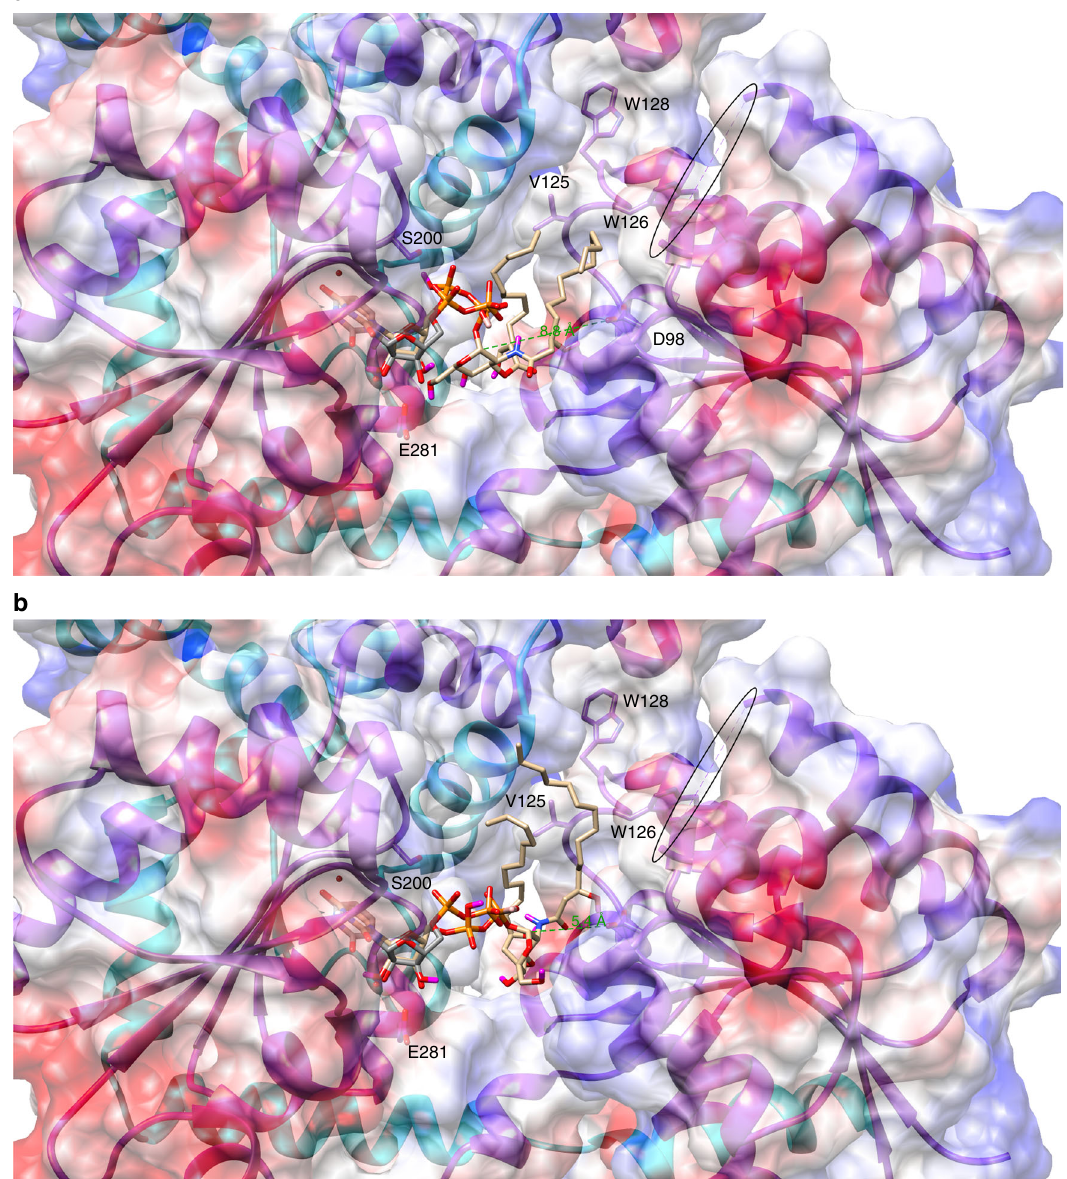
Fig. 6 Molecular docking model of UDP-DAG binding. UDP-DAG (tan carbons) was docked into the LpxB active site cleft with AutoDock Vina 56 . The software correctly identi fi ed the nucleotide-binding site overlaying reasonably well with the position of UDP (gray carbons) observed in the crystal structure. The lipid tails were predicted to extend toward a hydrophobic groove lined by V125, W126, and W128. The break in the chain corresponding to the disordered loop is circled. a The top ranked model places the anomeric carbon 8.8 Å from the predicted catalytic base, D98. b A lower ranked model (seven of nine) places the anomeric carbon 5.4 Å from D98, which would require less movement of the protein in order to correctly orient D98 and the 6 ′ - hydroxyl of lipid X for proton transfer and nucleophilic attack on the anomeric Although native LpxB6S bipyramidal crystals diffracted beyond 2.4 Å (Table 1), LiBr (Sigma-Aldrich), and 0.1M Tris-HCl pH 8.6. Switching from LiCl to LiBr was selenomethionine (Sem) derivative LpxB6S crystals that diffracted well enough for essential for obtaining harvestable LpxB7S Sem derivative crystals. phasing by single-wavelength anomalous diffraction could not be grown. E. coli LpxB has 13 Met, more than adequate for phasing a 42 kDa protein. We hypothesized that one or more of these methionines was interfering with crystallization in the Sem derivative, possibly by being surface exposed and decreasing protein solubility. Thus, we further utilized the Phyre2 homology model of LpxB to predict possible culprits. Three Met residues were identi fi ed and mutated to Ser; however, only M207S preserved the stability of LpxB6S as judged by size exclusion chromatography (Supplementary Fig. 1). M46S and M295S increased protein aggregation. Thus, the Sem derivative of LpxB6SM207S (LpxB7S) was selected for further crystal screening. Hexagonal rod crystals of the LpxB7S Sem derivative that diffracted to 3.43Å (Table 1) were obtained in a 2 μ l drop of 8 The selenomethionine anomalous diffraction data were used to calculate the mg ml − 1 LpxB7S (0.9 μ l), well solution (0.9 μ l), and 0.2 μ l of 100 mM trimethyl- initial phases and to build a crude model: AutoSol found 11 Se sites with a fi gure of ammonium chloride (Acros Organics) hanging over 500 μ l 28% PEG 4000, 0.35 M merit of 0.348 in space group P6 4 and built 201 residues in 16 fragments with an R-